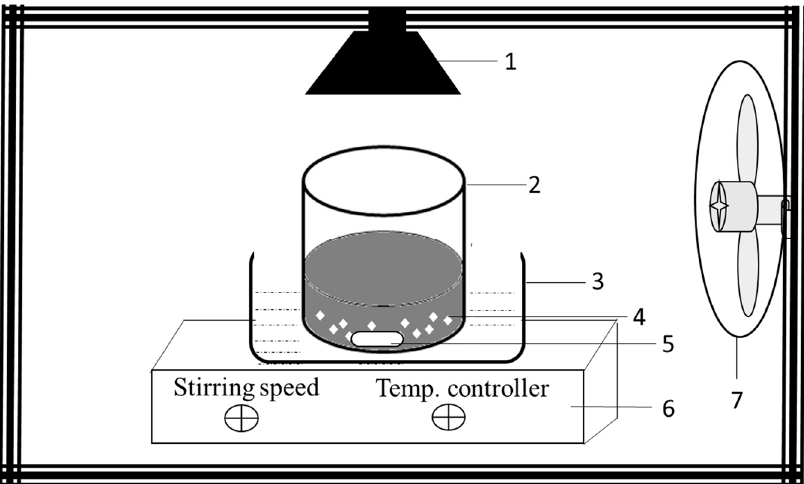
Figure 21. Scheme of the photocatalytic experimental setup; 1. Visible light source, 2. Reaction vessel 250 mL, 3. Water bath, 4. Photocatalysts, 5. Magnetic stirrer, 6. Stirring hotplate, 7. Cooling fan.